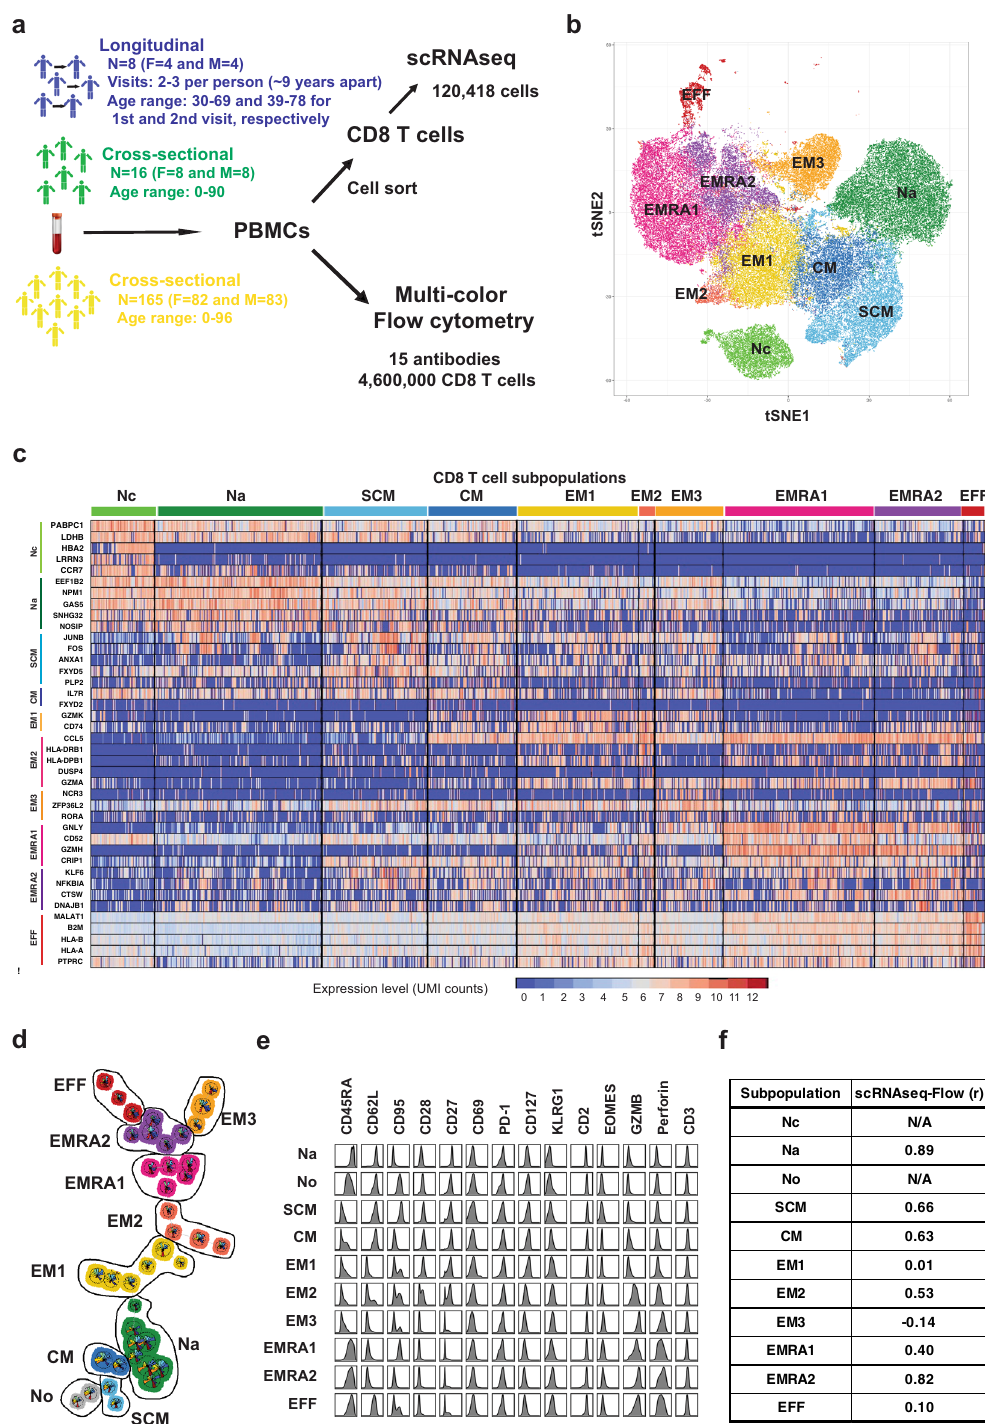
T EMRA2 )increasedin percentagewith age.ThepercentagesofT CM, T EM, and T EFF remained stable over time. The age-related changes were all signi fi cant in all subpopulations except T CM in the fl ow cytometry analysis, whereas only changes in T Na and T SCM were signi fi cant in scRNAseq analysis. This difference in statistical signi fi cance was likely due to the difference in cohort size ( fl ow cytometry cohort had 165 participants) whilethe scRNAseq cohorthad only24 participants). The consistency between the percentage change with age in subpopula- tions identi fi ed by both approaches further supported their utility as analogous techniques to study heterogeneity within CD8 + T cells.